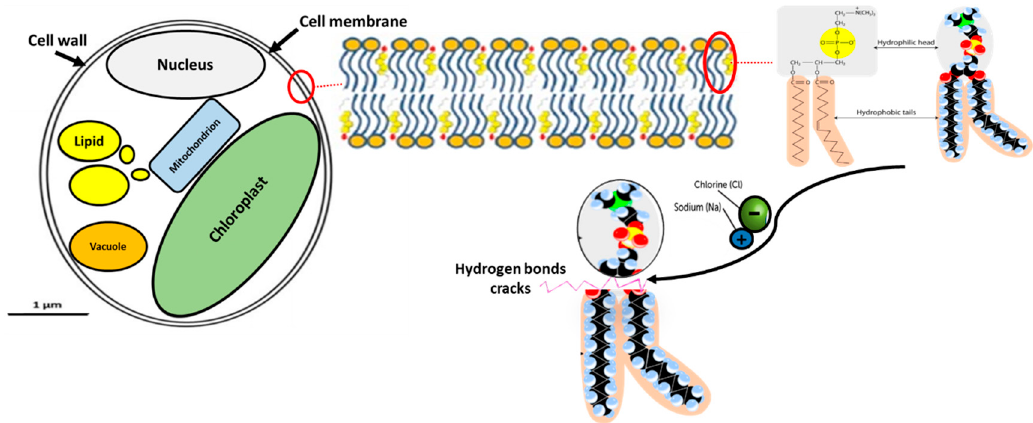
Figure 5. Illustration the e ff ect of NaCl ions on the microalgal cell wall cracks. Table 4. The extraction coe ffi cients, yields at equilibrium, and statistical parameters for lipid extraction